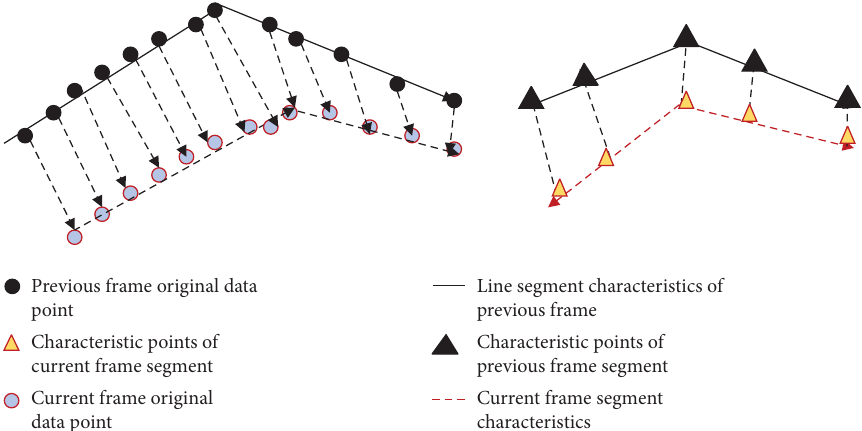
Figure 5: Schematic diagram of ICP based on line segment characteristics.